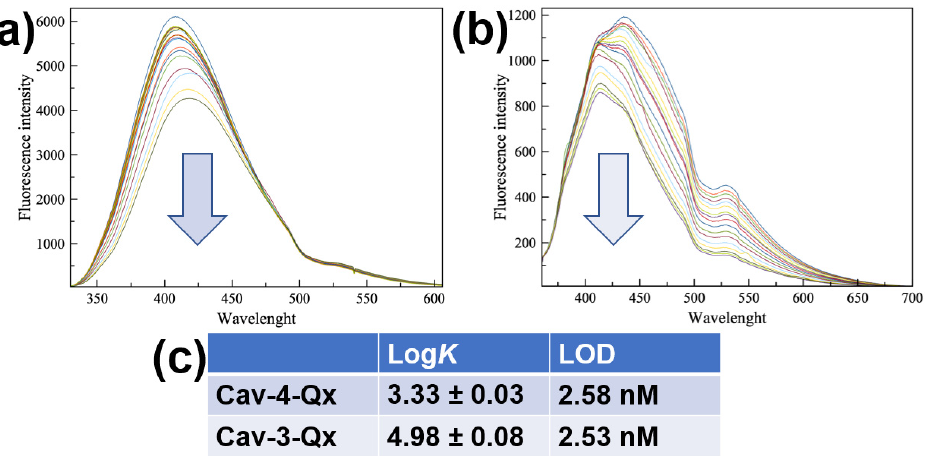
Figure 1. Fluorescence titrations between DA and Cav-4-Qx ( a ) and Cav-3-Qx ( b ) in CHCl 3 ((Host) = 1 × 10 − 5 M, (DA) = 0 ⁓ 1.13 × 10 − 4 M, λ ex 320 and 340 nm for Cav-4-Qx and Cav-3-Qx , respectively); ( c ) binding constant values of supramolecular complexes with DA calculated by HypSpec version 1.1.33 [54–57], detection limit was calculated by the method of the calibration curve, using the formula LOD = 3 σ /K, where s is the standard deviation of the blank and K is the slope of the calibration curve.